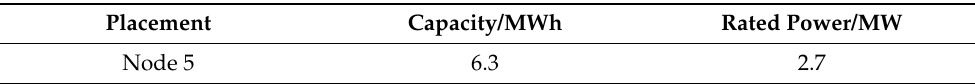
Table 18. Results of the BSS dimensioning for the planning variant combining underground cables and BSS.